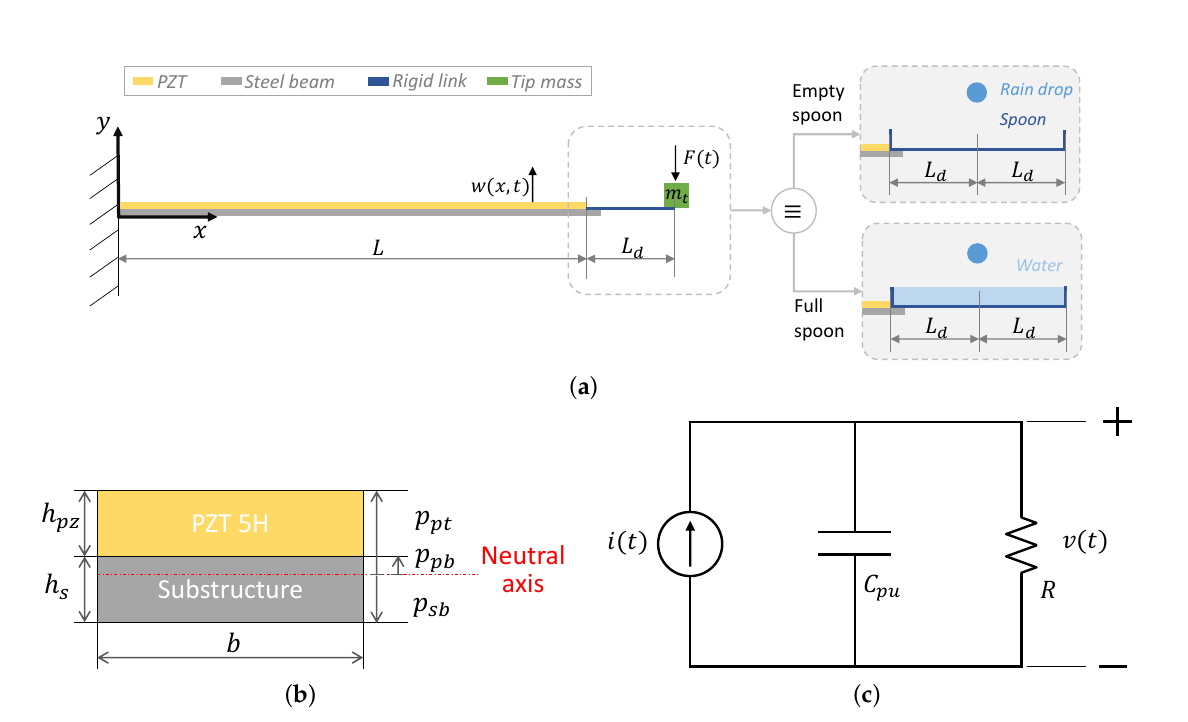
Figure 10. Harvester model: ( a ) equivalent mechanical schematic; ( b ) composite cross section; ( c ) electrical